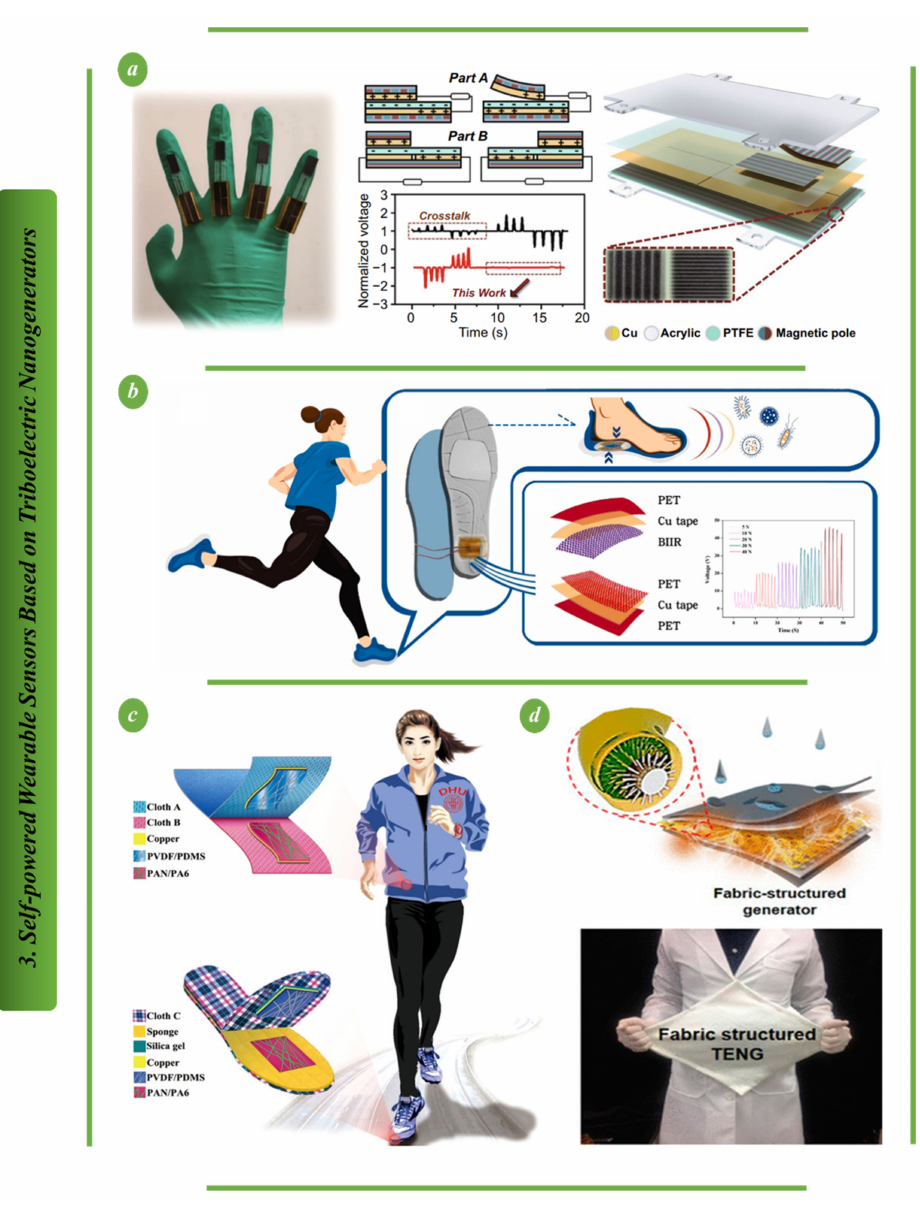
Figure 3. Self-powered wearable sensors based on TENG: ( a ) Multilayer structure of the Ma-s-TS [83]. ( b ) A schematic representation of a triboelectric nanogenerator that was built using bromobutyl rubber (BIIR) and PET [84]. ( c ) Fabricating an NM-TENG for use in wearable electronics [85]. ( d ) Depicting the stages of the FTENG’s manufacturing process